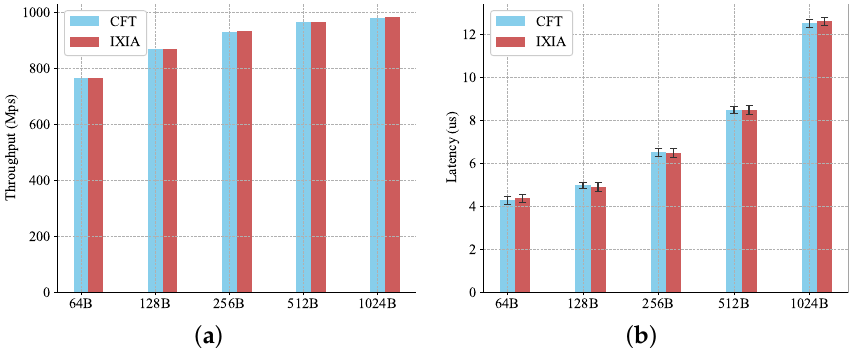
Figure 9. The comparison of the performance between the CFT and the IXIA network tester regarding the throughput and latency; ( a ) throughput, ( b ) latency.